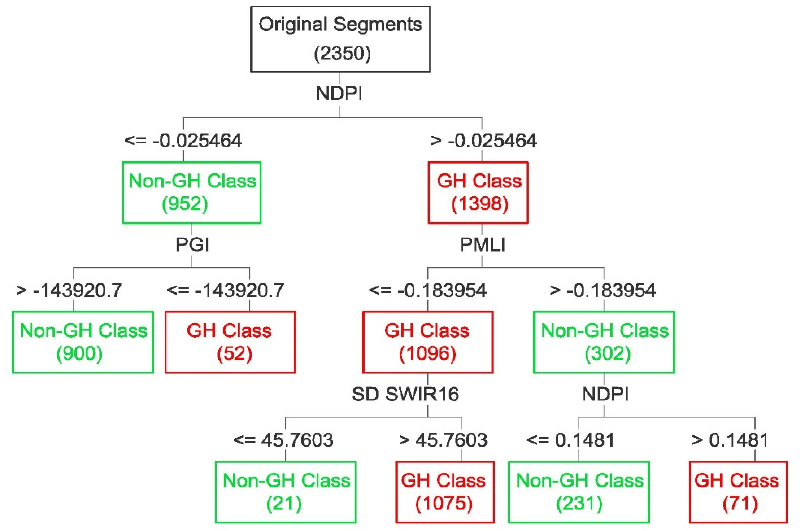
Figure 4. Decision tree (DT) model proposed for All Features strategy (greenhouse class (GH), non-greenhouse class (Non-GH)).